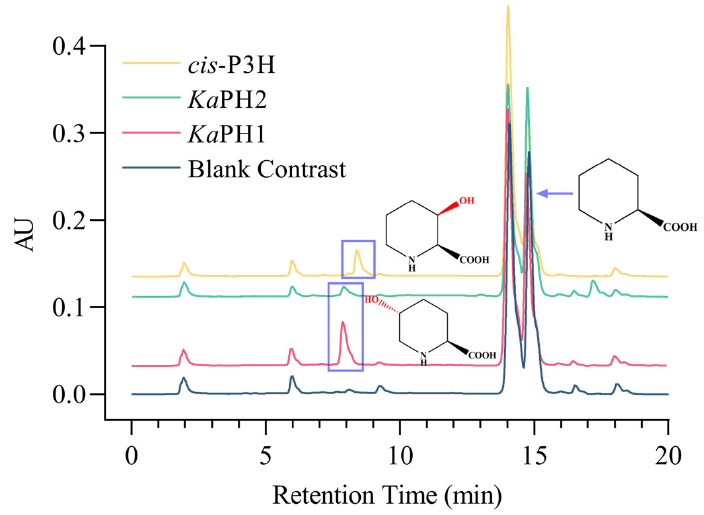
Figure 2. Recombinant proteins with catalytic activity toward the substrate, L-Pip. The blank contrast was the same as the experimental group except for the addition of buffer instead of enzyme.